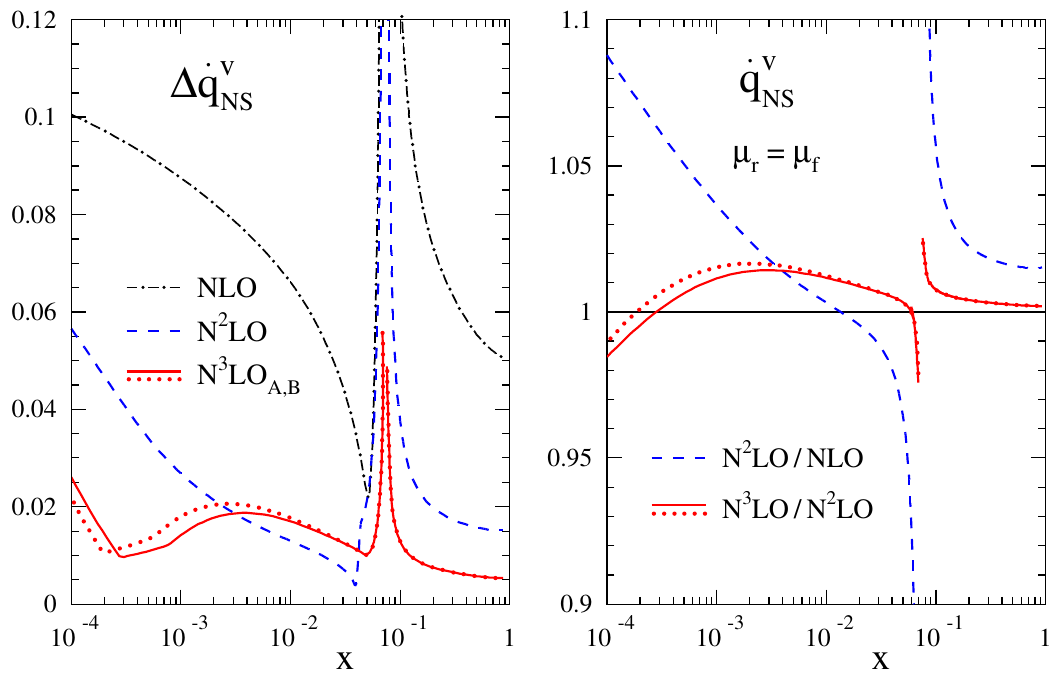
Figure 12 . As (cid:12)gures 10 and 11, but for the total ((cid:13)avour-summed) valence quark distribution q v . Here and in (cid:12)gures 10 and 11 the spikes close to x = 0 : 07 re(cid:13)ect the sign-changes of _ q i ns not constitute appreciable absolute corrections and uncertainties. All three (cid:12)gures refer to n and (cid:11) s ( (cid:22) 2 = (cid:22) 2 ) = 0 : r f